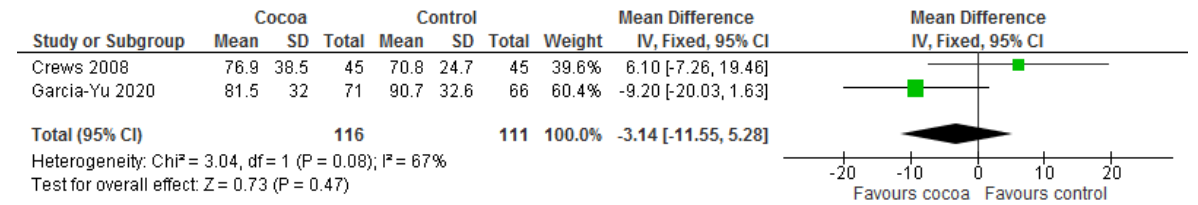
Figure 14. Forest plot of comparison: chocolate versus control, with the outcome - trail marking test (attention) (seconds).